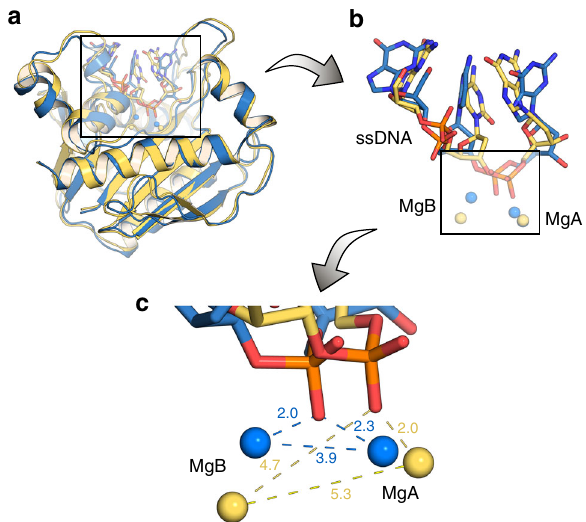
Fig. 8 Comparisons of the exonuclease active site of wild-type and P301R Pol2 CORE after molecular dynamics simulations. Overlay of structures of the exonuclease active site of wild-type (blue) and P301R Pol2 CORE (yellow), taken as representative snapshots from 3 × 200 ns simulations of each system, and zooming in progressively from ( a ) the full tertiary structure to ( b ) the exonuclease-site to ( c ) the metal binding site. As can be seen, the proposed bridging conformation of the phosphate group from the ssDNA backbone is lost in the P301R variant, due to displacement of the Mg 2 + ion in the B-site. The distances annotated in ( c ) are average distances (Å) over the entire simulation and all